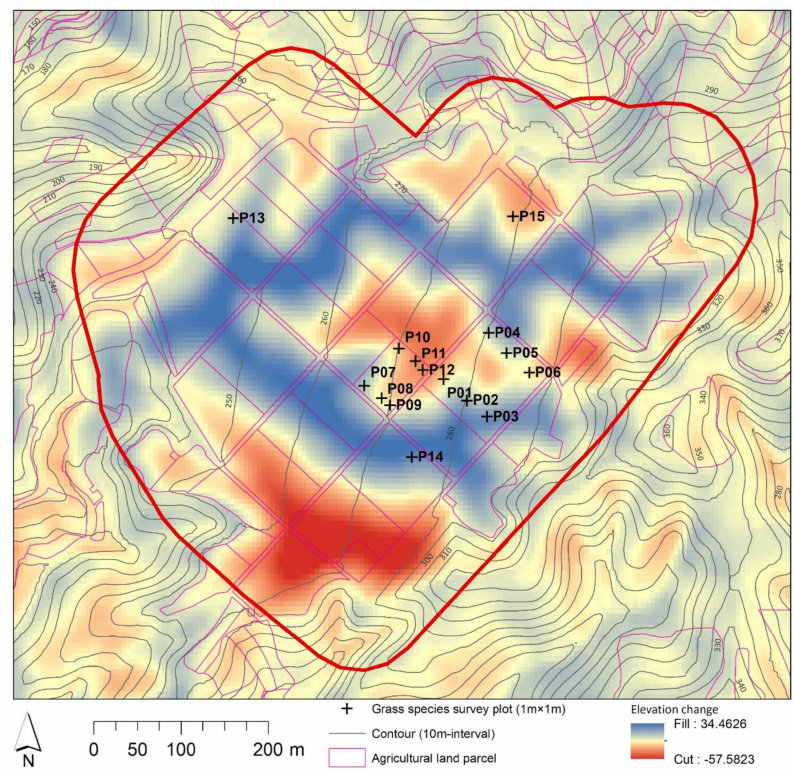
Figure 6. Anthropogenic landform transformation in the Ume orchard pilot